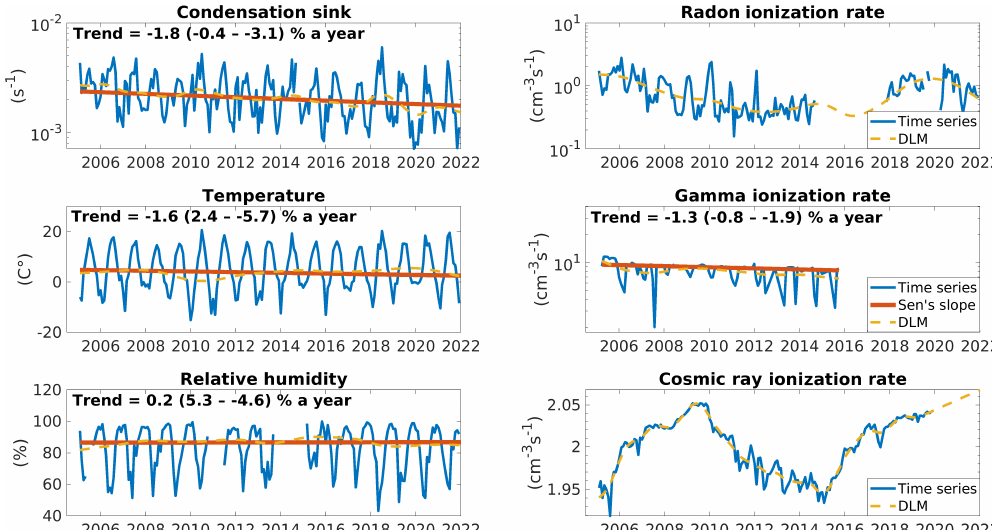
Figure 5. The time series of main sources and sinks as well as temperature and relative humidity. The relative changes per year have been calculated from Sen’s slopes. The values in brackets are the confidence intervals for the trend at a 90%